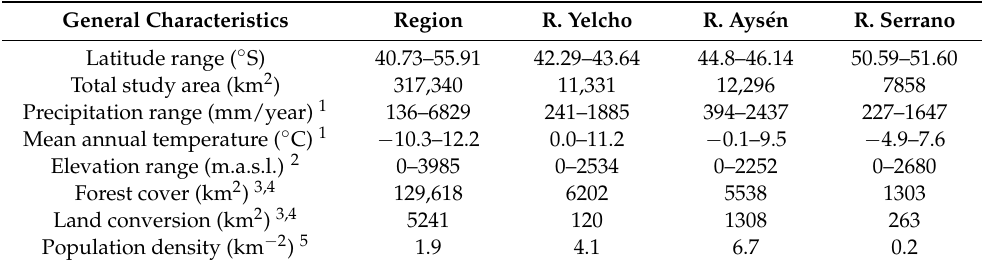
Figure 1. Mapping extent for intact forested watersheds (IFW) in Southern Patagonia. The regional mapping of potential IFW was based on mature forest cover extracted from detailed forest stand mapping (available only for the Chilean side of binational and trans-Andean basins, Table 1), from 41 to 56° S. Validation using high resolution satellite imagery was done for three major binational basins: Río Yelcho, Río Aysén and Río Serrano. Also indicated are boundaries for all major watersheds, and political jurisdictions (inset right). Table 1. Attributes for regional mapping area (Chile) and the three validation basins.